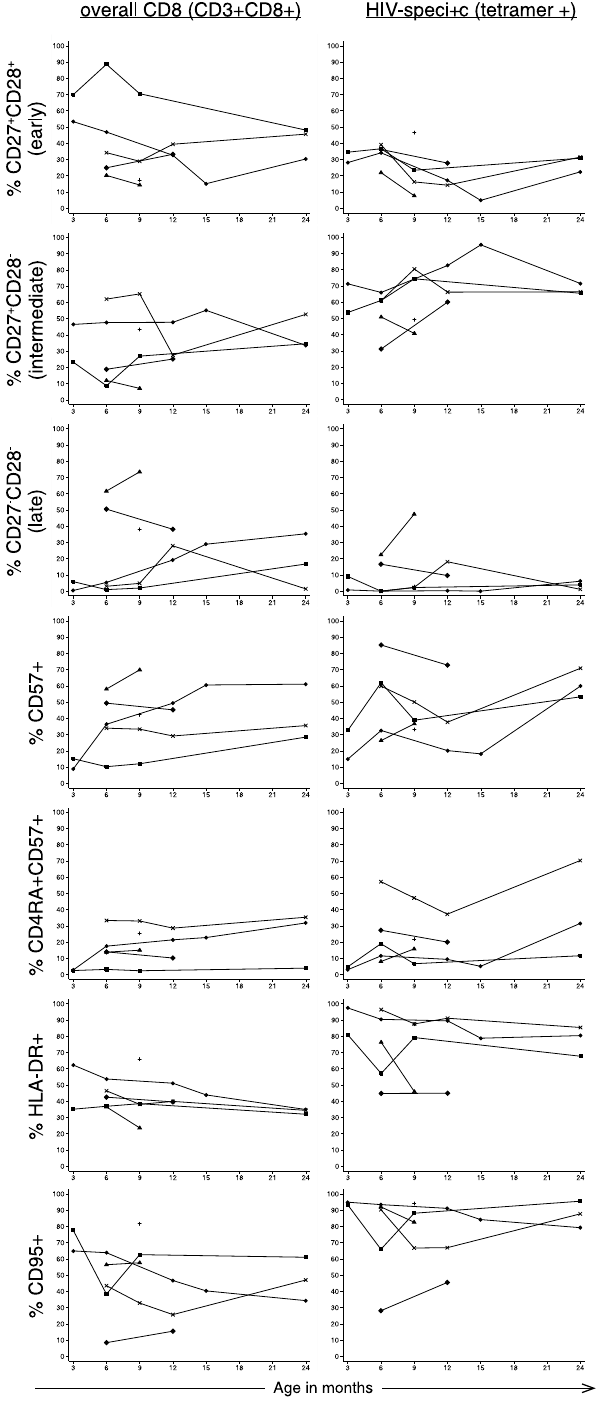
Figure 3. Changes in the overall and HIV-specific CD8 + T cell subsets during the first two years of infection. The frequency of HIV-specific CD8 + T cells and overall CD8 + T cells expressing each marker or combination of markers are shown for the first two years of life. All infants were infected by 1 month of age. Connected gray lines show individual infants with more than 1 measurement of phenotype (N=5), one infant had only one time point analyzed for phenotype (B1- 334, + symbol).